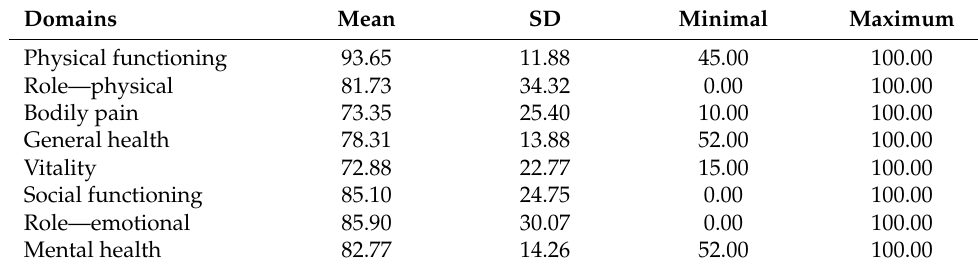
Table 4. Results of the SF-36 Health